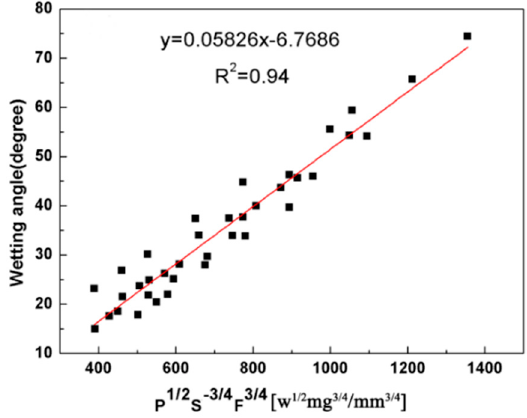
Figure 8. Relationship between dilution and P 1/8 S 1/5 F − 1/2 .